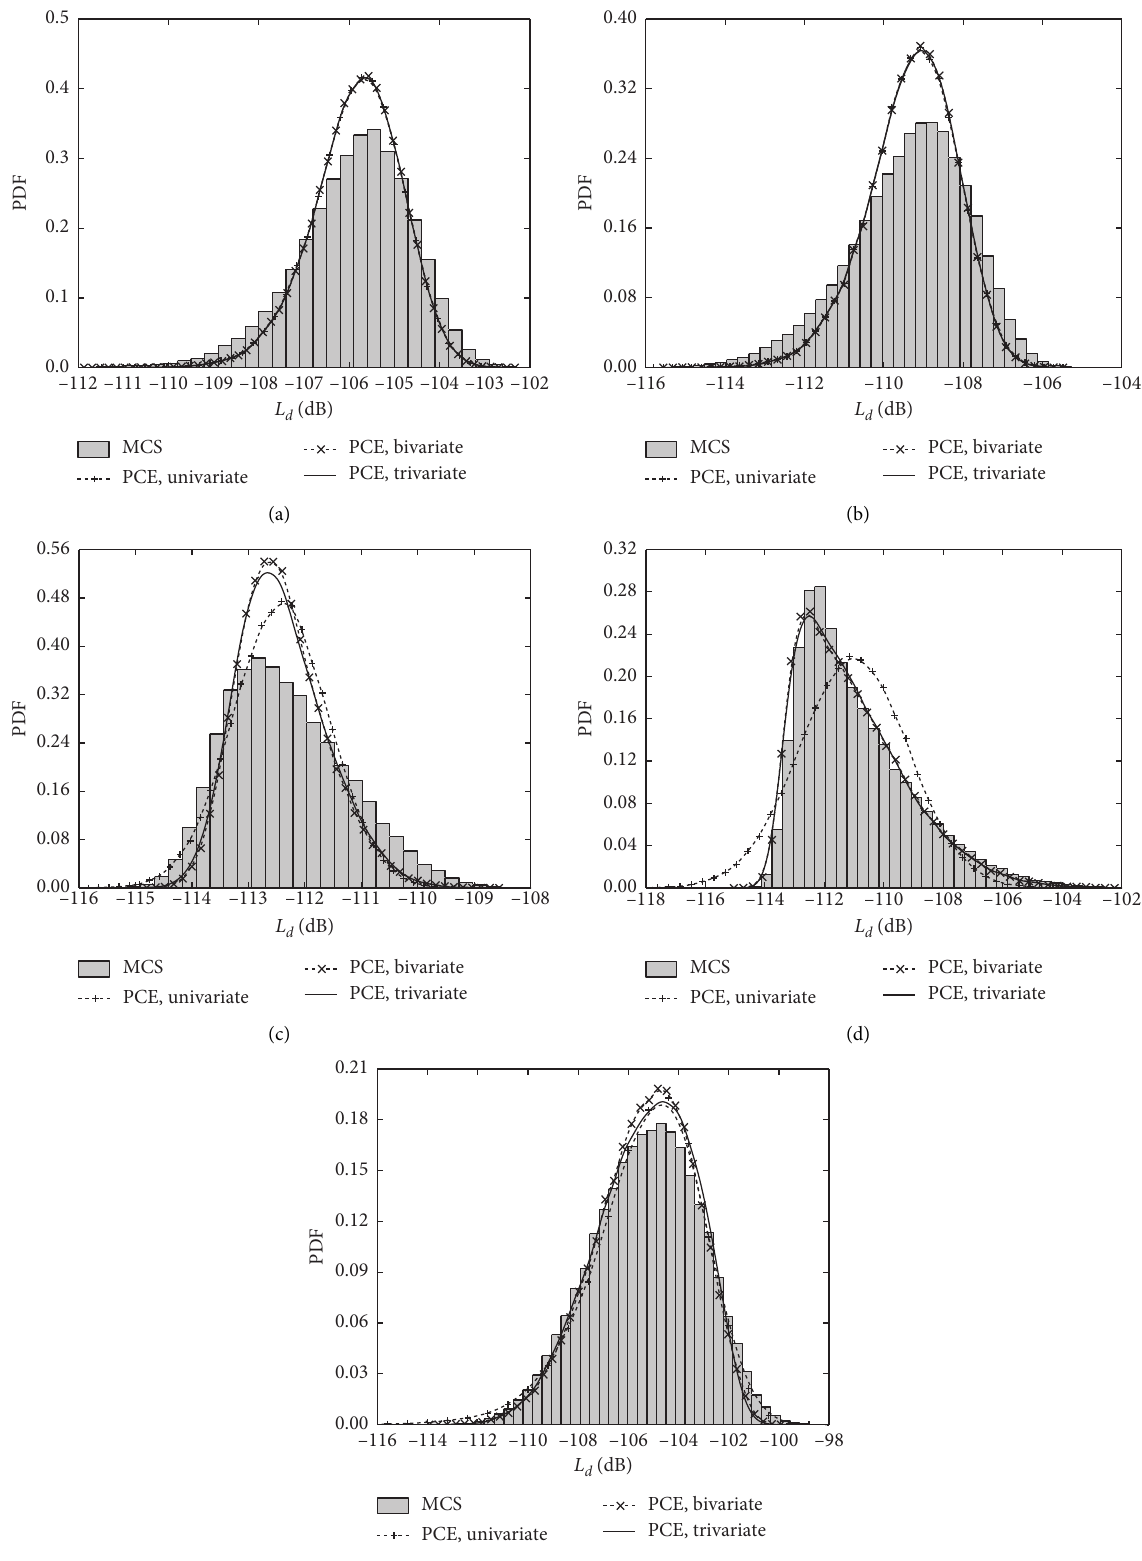
Figure 5: PDFs of the dynamic compliance amplitude within 18 ∼ 22 Hz. (a) 18Hz. (b) 19Hz. (c) 20Hz. (d) 21Hz. (e)